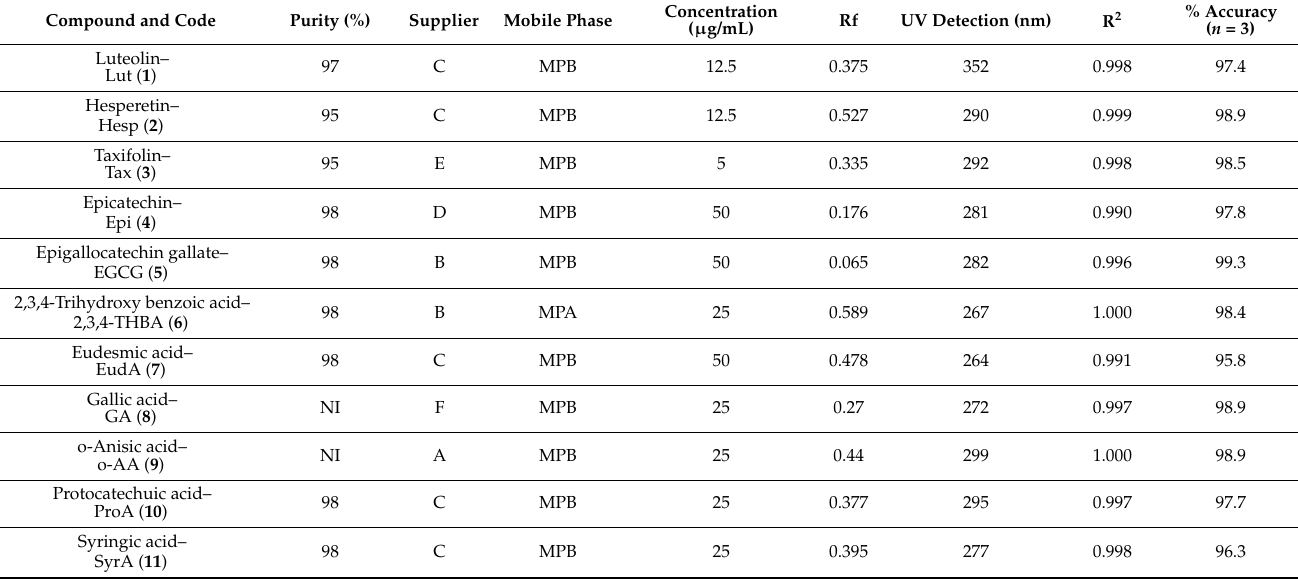
Table 1. Key parameters for the phenolic standards applied in the quantification